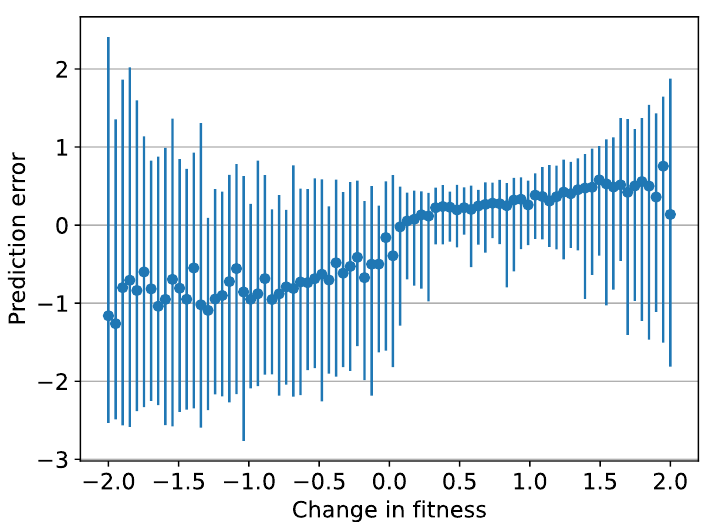
Figure 4. Mean prediction errors at the end of simulation. Each point represents the population mean for one of the 80 situations, and each corresponding vertical bar shows the range within the population.